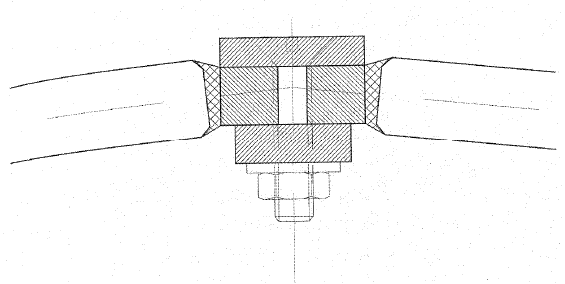
Figure 3: Details of the connections of Jan Wurms dome (glass thickness 6 mm).